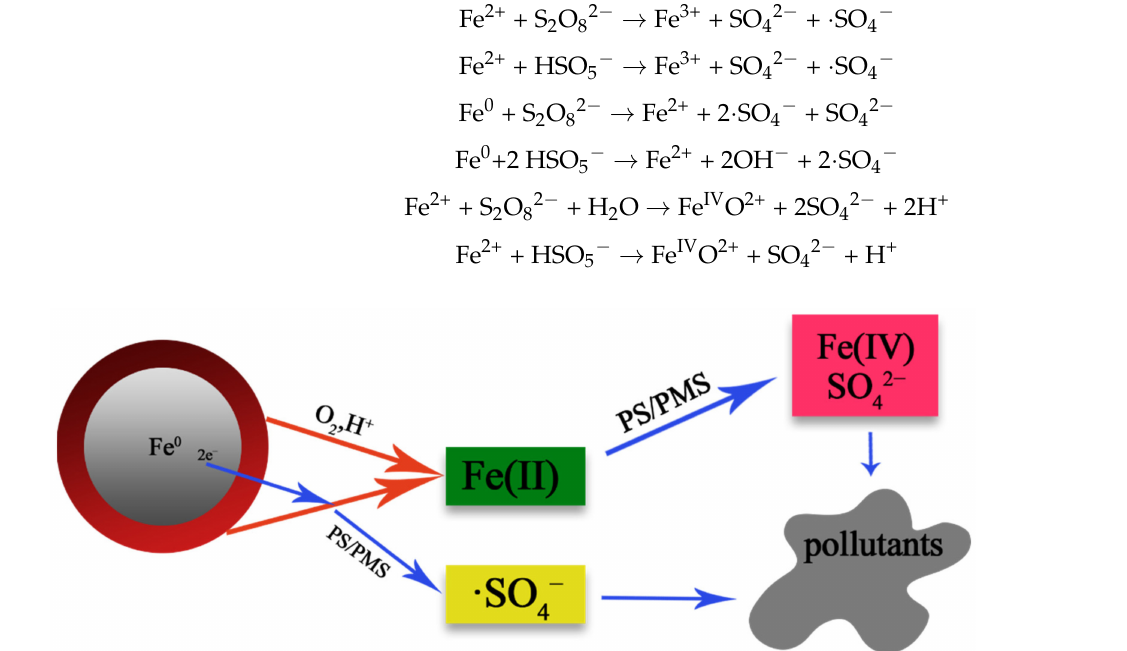
Figure 5. Schematic of the formation of · SO 4 − and Fe(IV) in nZVI/persulfate systems containing methyl phenyl sulfoxide [81].